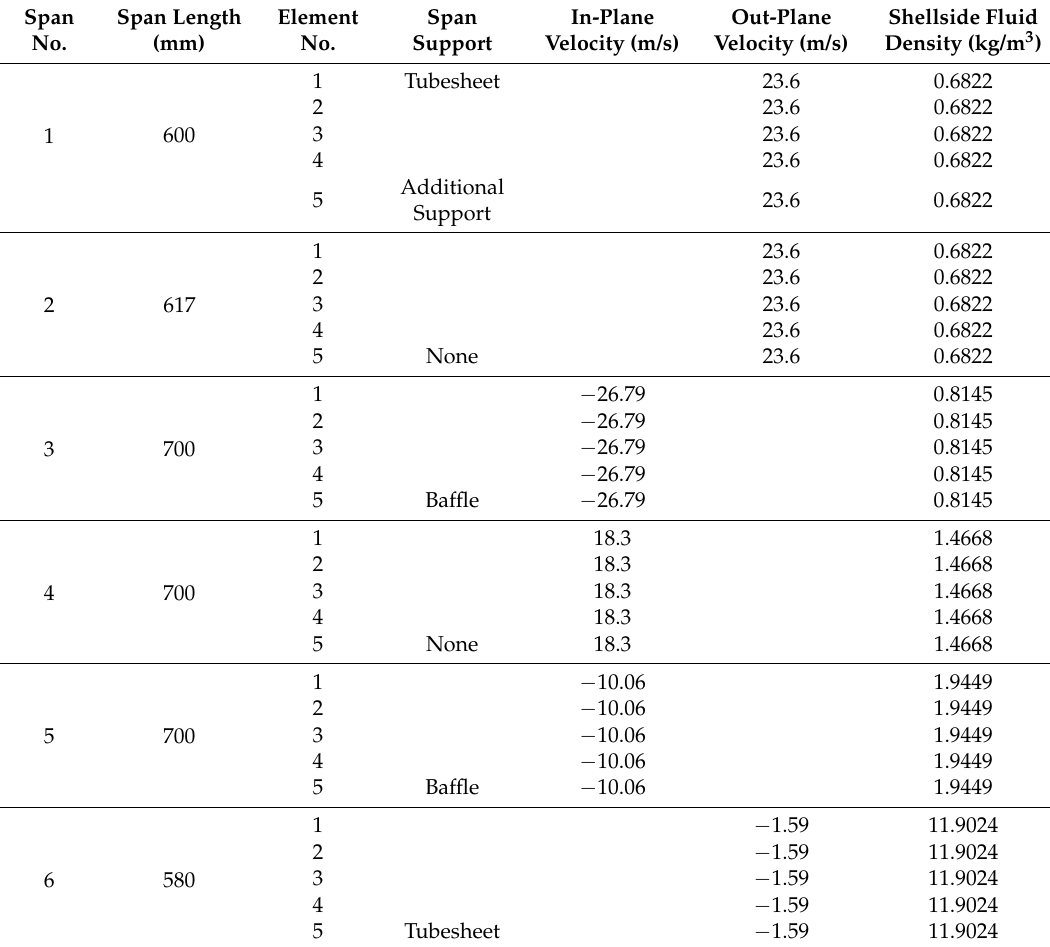
Table 11. Tube span profile from Xvib input